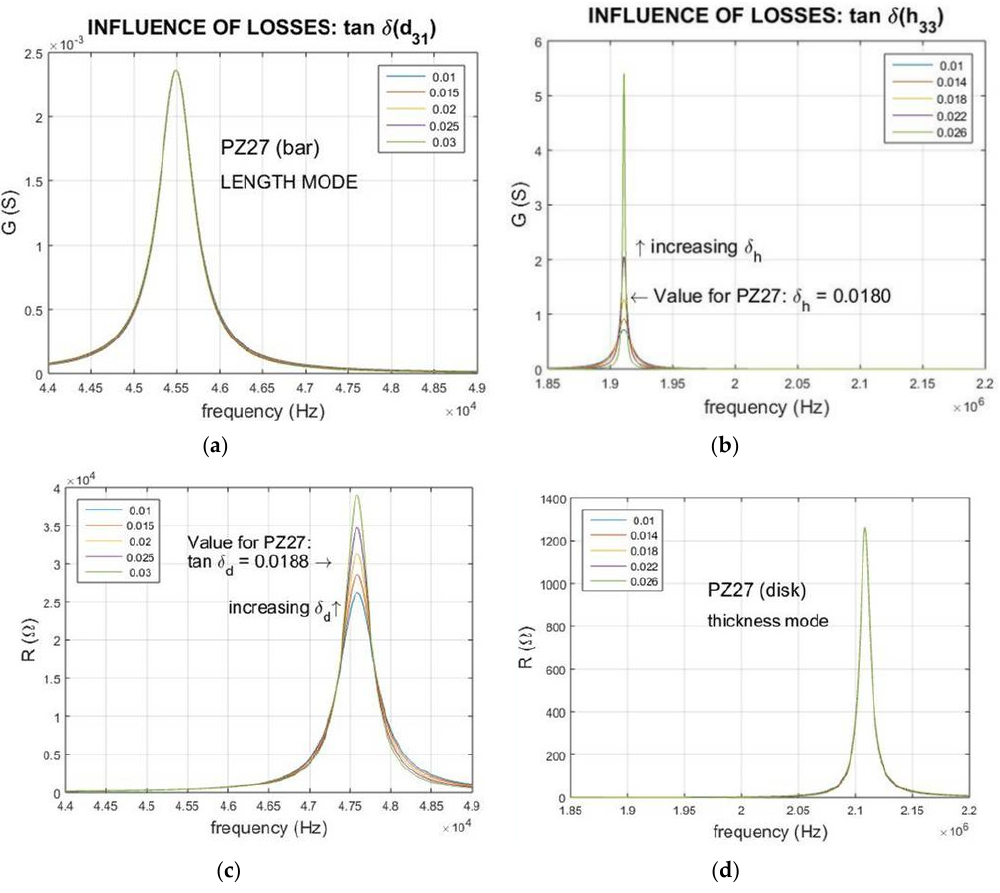
Figure 8. Influence of piezoelectric losses on the ( a ) resonance and ( c ) anti ‐ resonance peaks for length extensional mode of a thickness poled bar; loss of d 31 modifies the mechanical anti ‐ resonance peak ( R ‐ peak). Influence of piezoelectric losses on the ( b ) resonance and ( d ) anti ‐ resonance peaks for thickness mode of a thin disc, the losses of the h 33 factor modify the mechanical anti ‐ resonance peak ( G ‐ plot) .